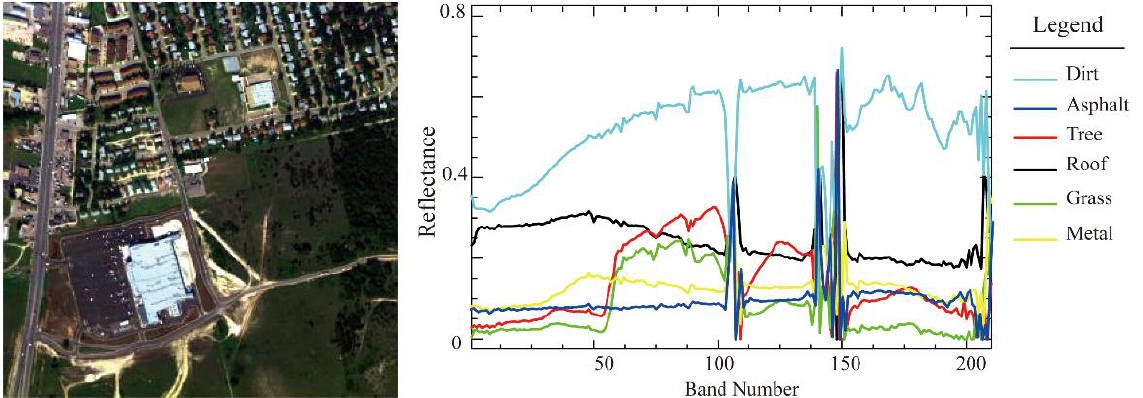
Figure 3. The Jasper Ridge data shown in RGB form and ground truth endmembers.